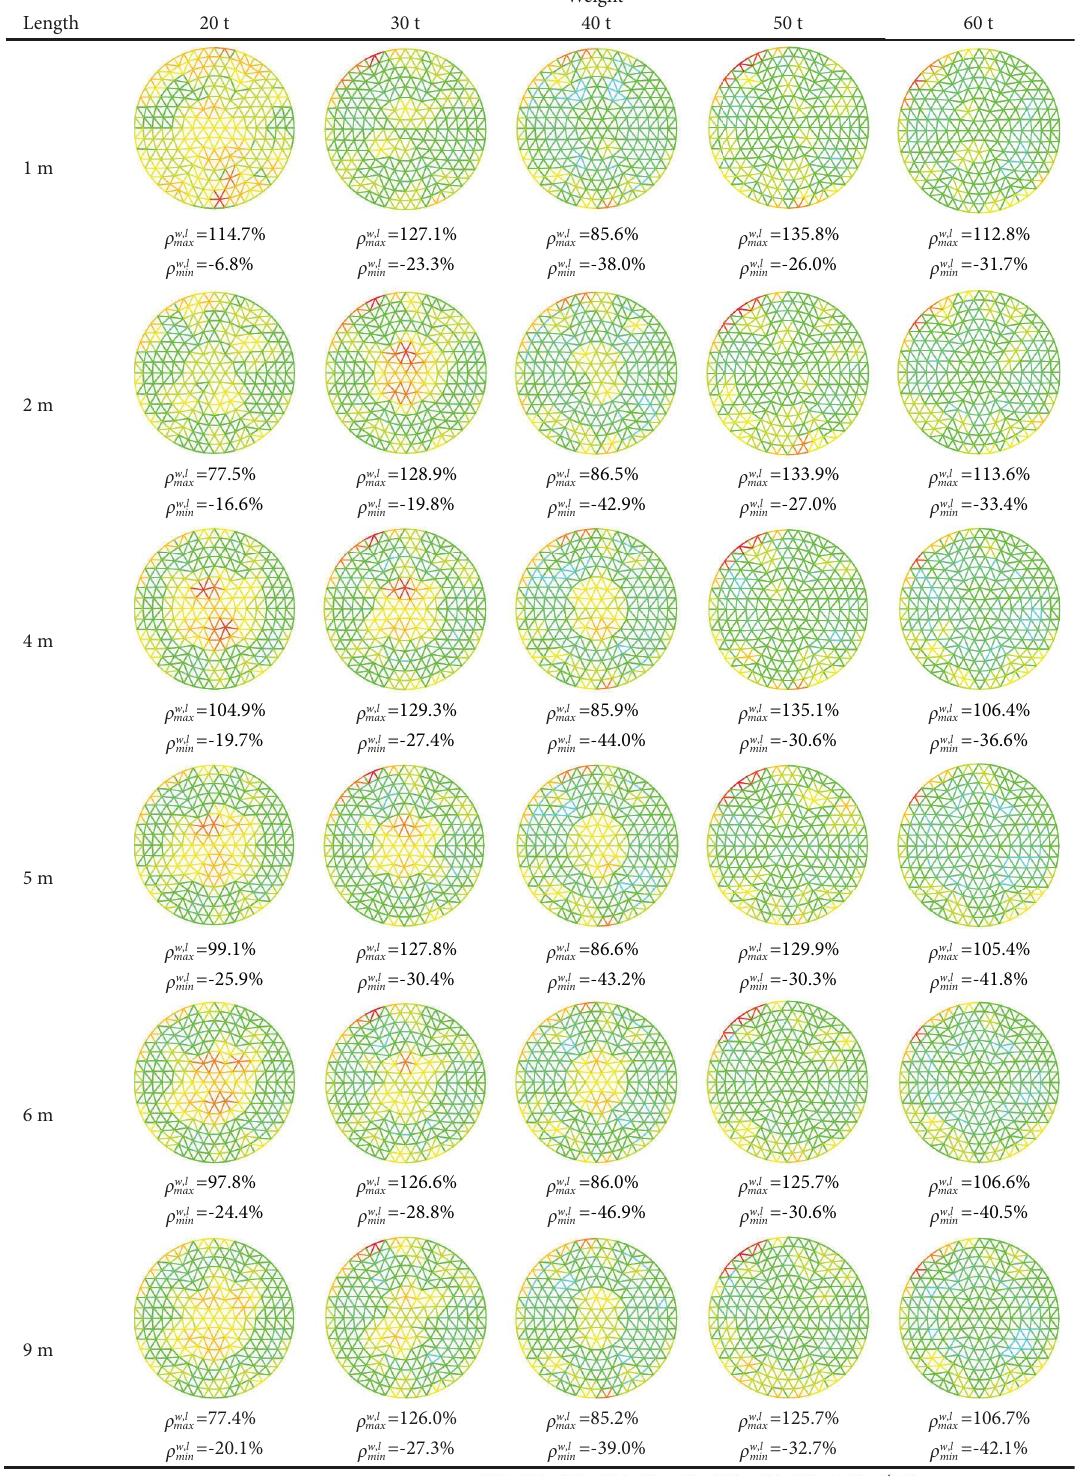
Table 4: Contours of the ρ w,l